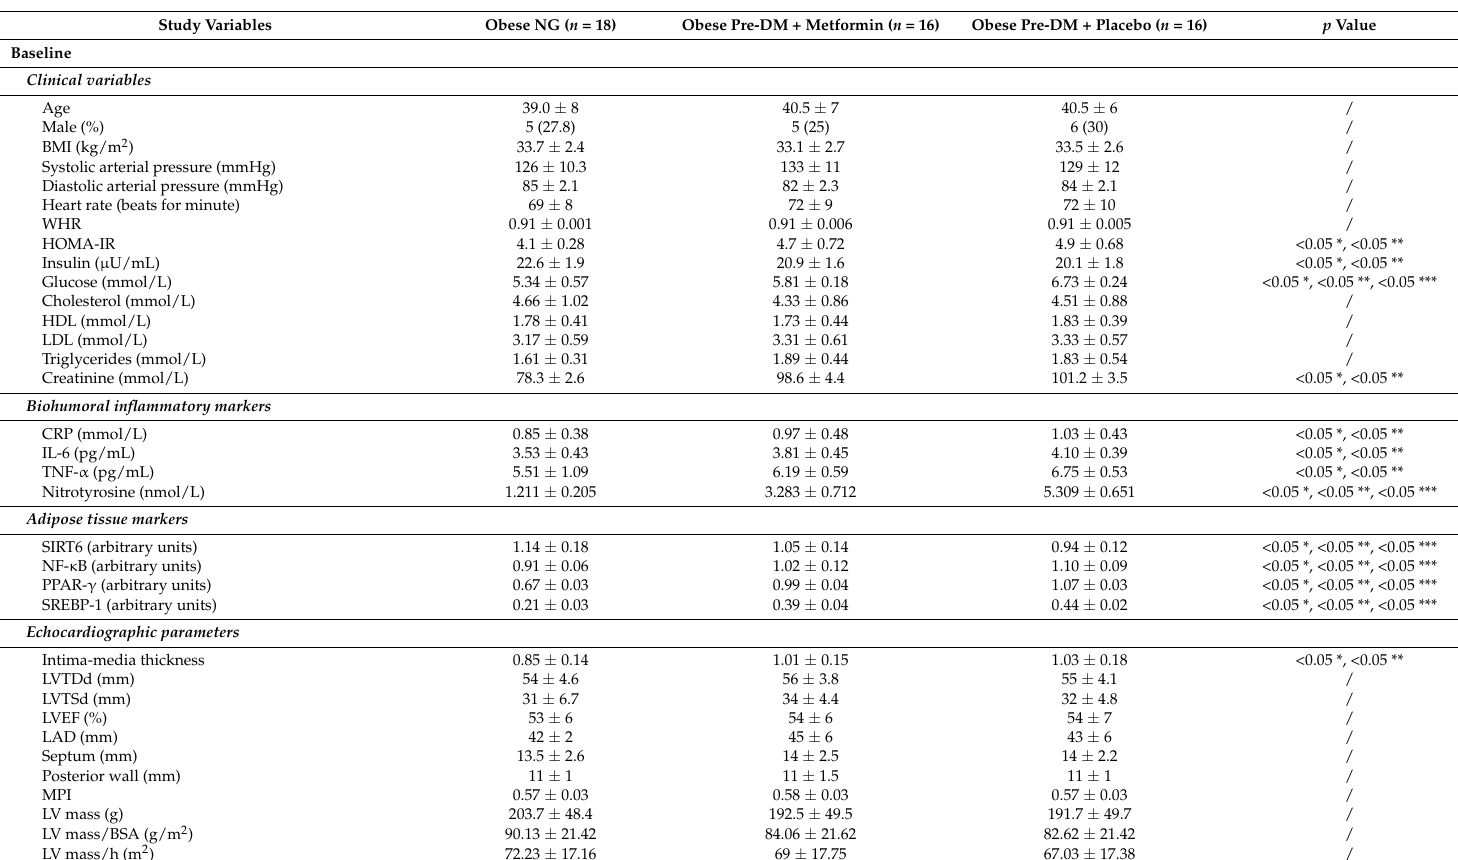
Table 1. Clinical characteristics of study population. Study variables (biohumoral markers, echocardiographic parameters, fasting glucose, insulin, insulin resistance, lipid values and drug therapy) of study population of 50 patients divided in three groups at baseline: group 1, obese normoglycemic patients (NG) treated with hypocaloric diet ( n = 18); group 2, pre-diabetic (pre-DM) obese patients treated with hypocaloric diet added to metformin ( n = 16); group 3, pre-DM obese patients treated with hypocaloric diet added to placebo ( n = 16). * p < 0.05 for the comparison of group 1 vs. group 2; ** p < 0.05 for the comparison of group 1 vs. group 3; *** p < 0.05 for the comparison of group 2 vs. group 3. The symbol/indicates a value not statistically